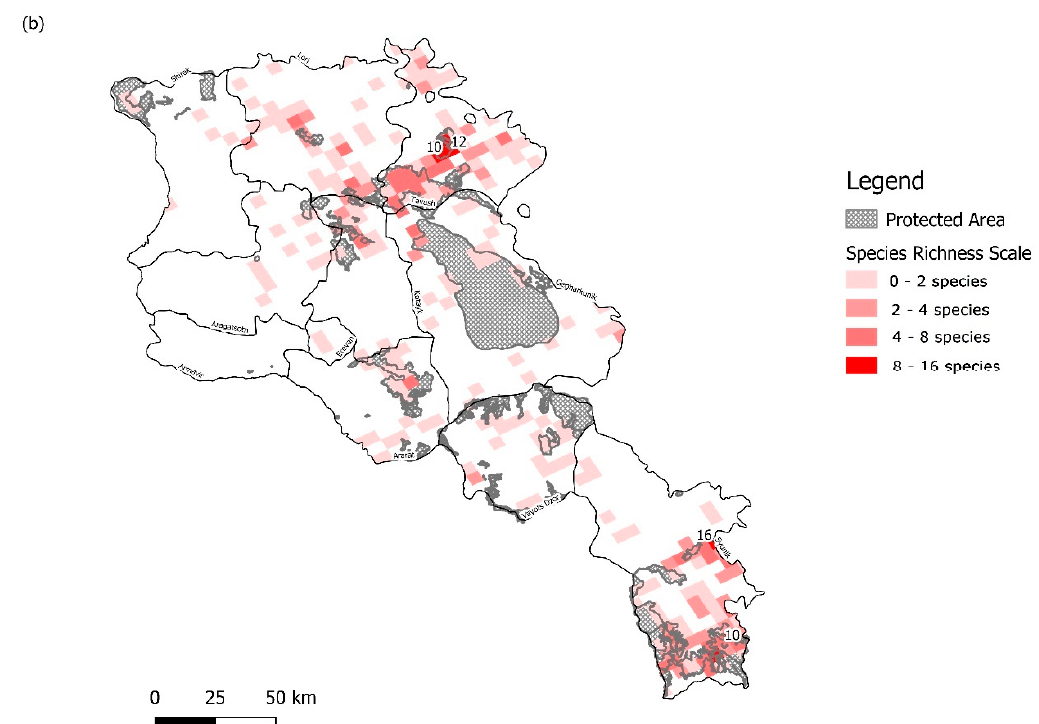
Figure 1. Map showing ( a ) a heatmap of orchid observations (genera distribution can be found in Figure S1: Map of genera distribution) and ( b ) species richness within the territory of Armenia, derived from herbarium vouchers, field visits and GBIF records (1101 total data points). Heat map developed using the Kernel Density Estimation with a radial distance buffer of 5 km is graded from yellow to red showing increasing observational findings. Location of Protected Areas derived from the World Database of Protected Areas is also mapped across the study site for comparison.